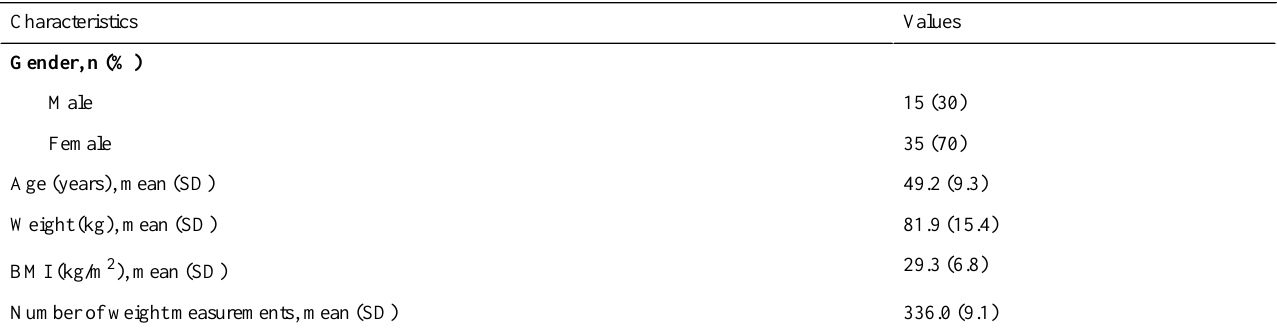
Table 1. Participant characteristics (N=50).